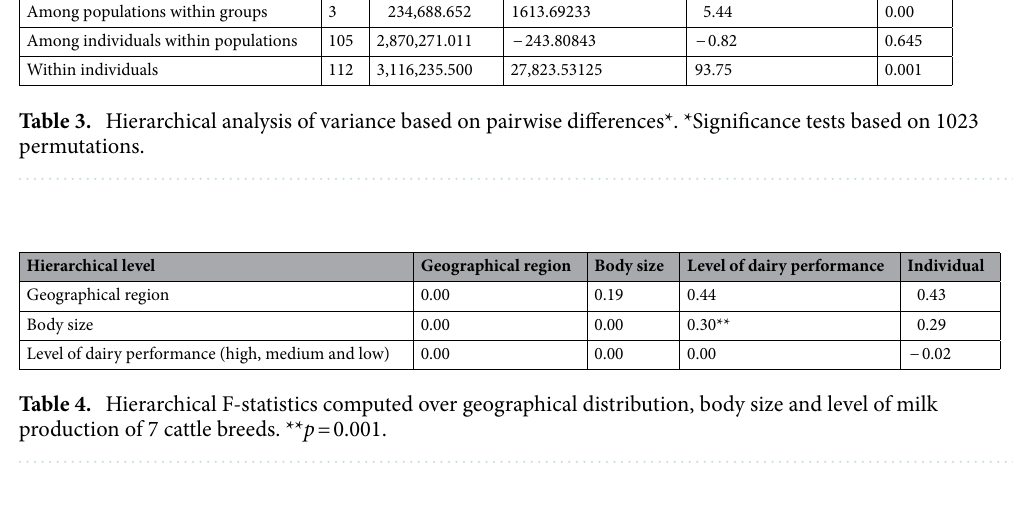
Source of variance d.f Sum of squares variation components Percentage of variation p value Among groups 3